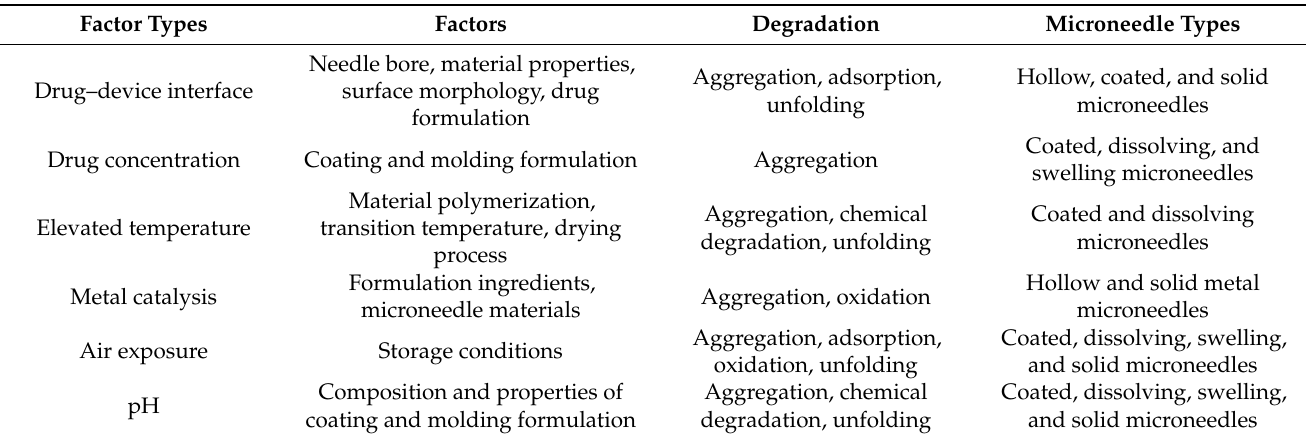
Table 1. Biomolecule degradation in microneedles